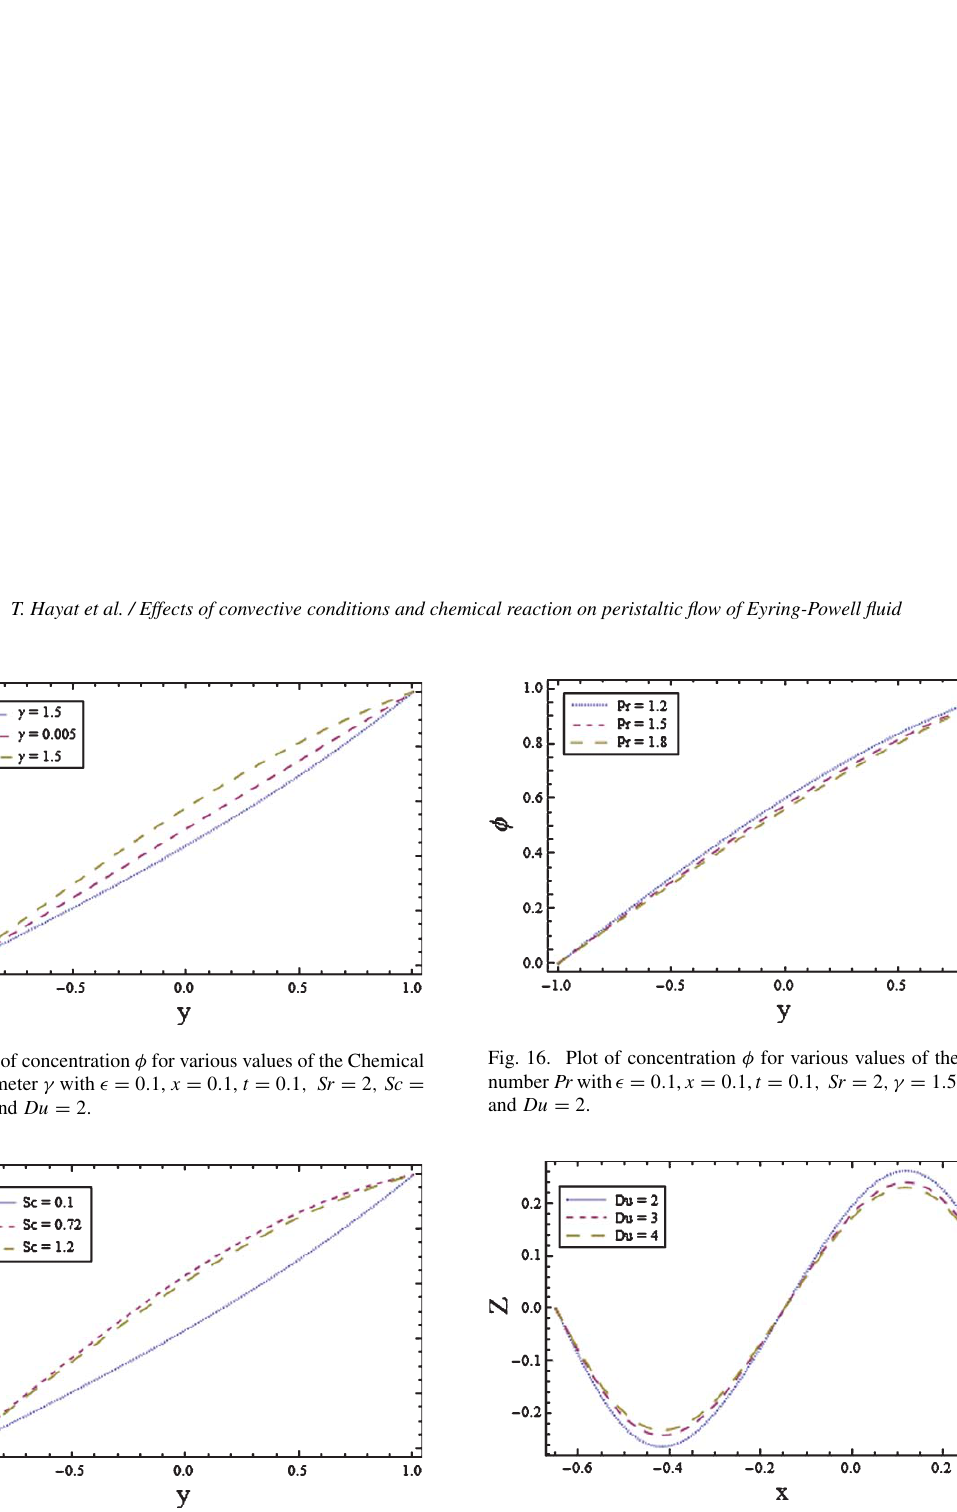
Fig. 15. Plot of concentration φ for various values of the Schmidt number Sc with (cid:15) = 0 . 1, x = 0 . 1, t = 0 . 1 , Sr = 2 , γ = 1 . 5 , Pr = 1 . 2 and Du = 2 .